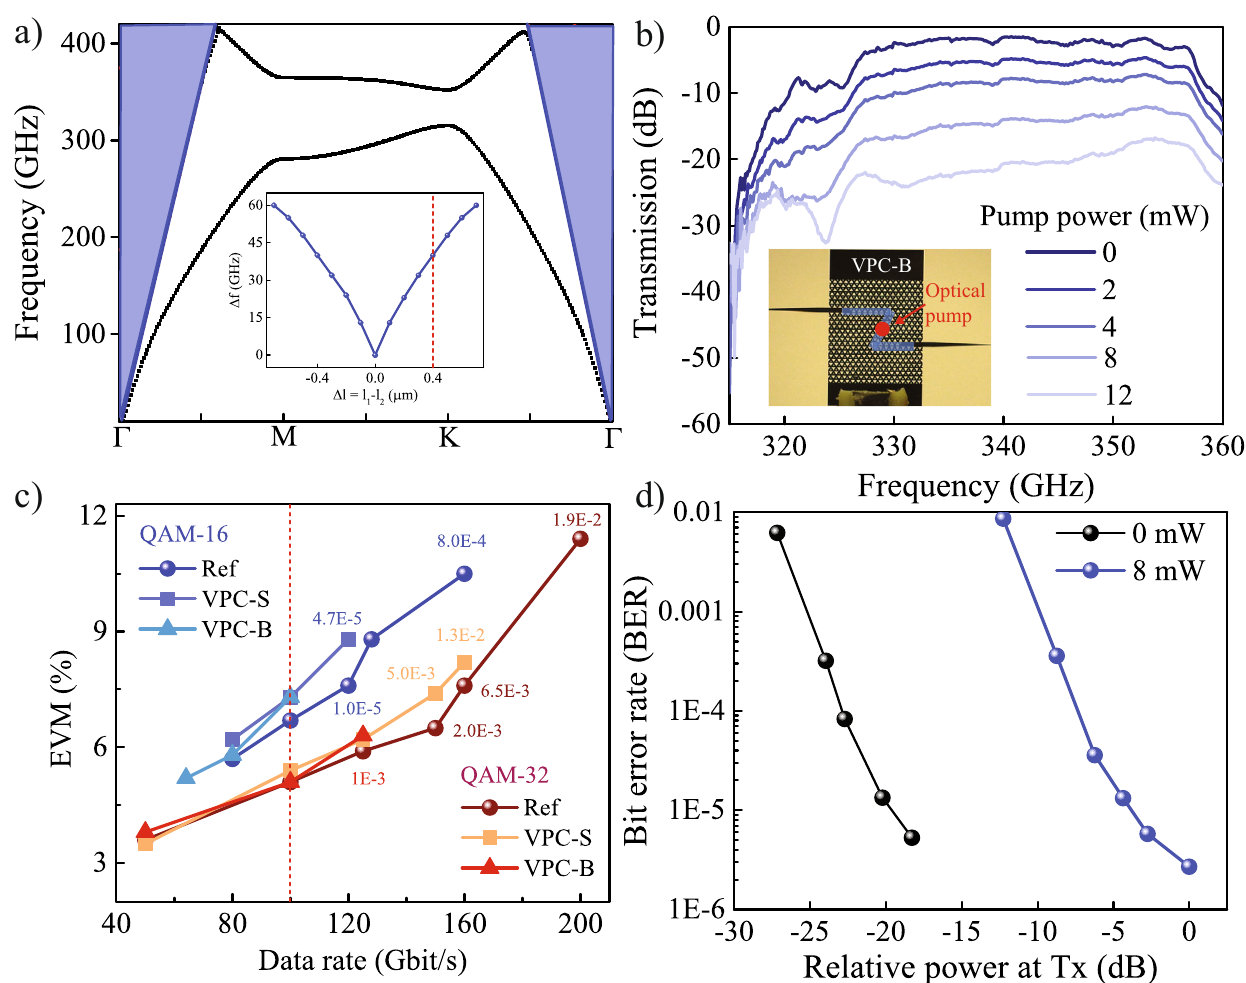
Fig. 2 | Beyond 100Gbit/s phototunable silicon Valley-Hall photonic crystal THz waveguide. a Photonic band diagram calculated using COMSOL Multi- physicsforSi-VPCchipwith l 1 and l 2 equalto0.70 a and0.30 a respectively.Inset shows the variation in bandgap as a function of the difference in triangular hole size ( Δ l = l 1 − l 2 ). b Measured transmission from VPC-B chip at various photo- excitation pump power. Inset shows the optical image of the fabricated VPC-B chip where the blue region highlights the domain walls. The red dot represents the photoexcitation position at the domain wall. c Error vector magnitude